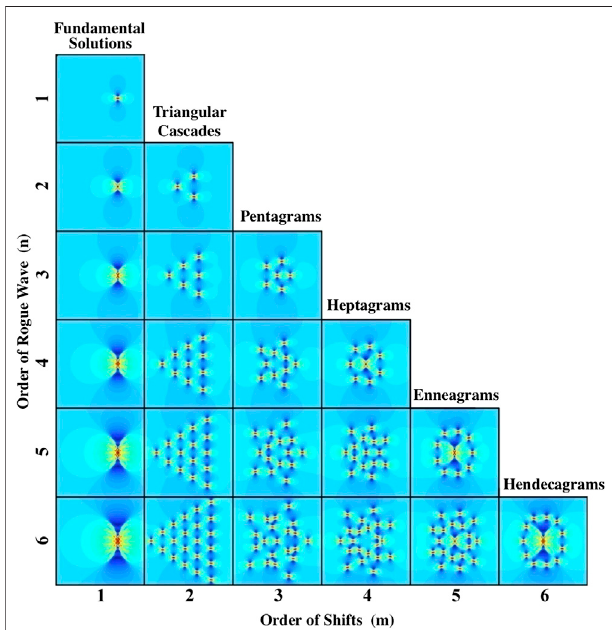
FIGURE 5 | Patterns of higher-order rogue wave solutions [72]. Only solutions of up to order six are shown. The Peregrine soliton is on the fi rst row. Second-order solutions are of two types: the AP solution and the triplet. They are located in the second row. Variety of patterns increases with the order. For example, the third order solutions do exist in the AP, triangular and pentagram forms. This happens because of the larger number of free parameters in the solution. Patterns located along the diagonal line are circular. They have a ring of ( 2 N − 1 ) Peregrinesolitonsaroundacentralroguewaveoforder N − 2(for N > 2). These are basically “ atomic structures ” with a nucleus and a shell of “ electrons ”